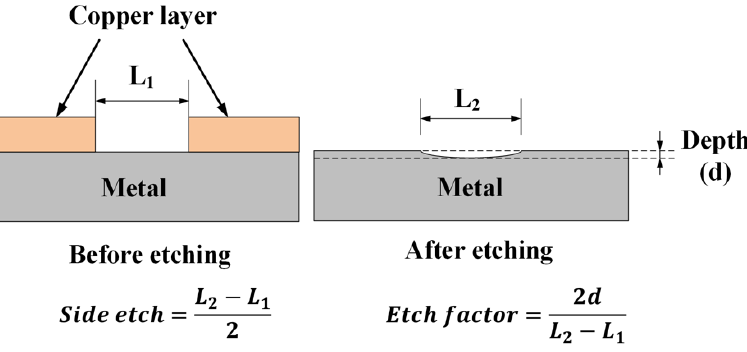
Figure 4. Shape evolution and etch factor in electrochemical etching.